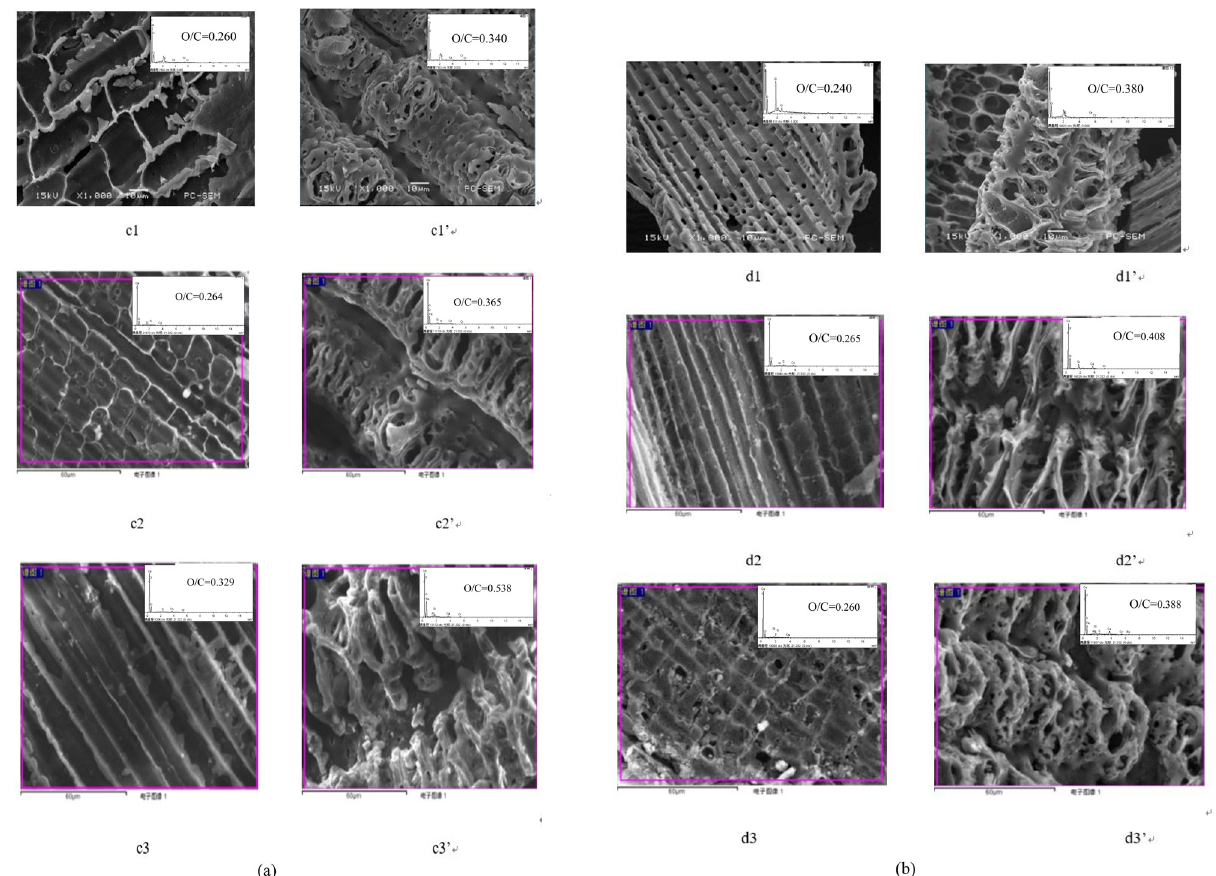
Figure 1: SEM - EDS analysis of the aged biochar samples. ( a ) c1 ( c1 ʹ ) , c2 ( c2 ʹ ) , and c3 ( c3 ʹ ) show the SEM - EDS images of the inner ( outer ) R350 after 0, 120, and 240 d incubation; ( b ) d1 ( d1 ʹ ) , d2 ( d2 ʹ ) , and d3 ( d3 ʹ ) show the SEM - EDS images of the inner ( outer ) R550 after 0, 120, and 240 d incubation.